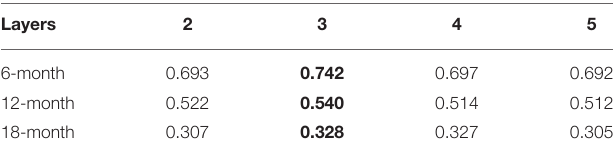
TABLE 2 | Correlation skill (Corr) of lead times with different layers.